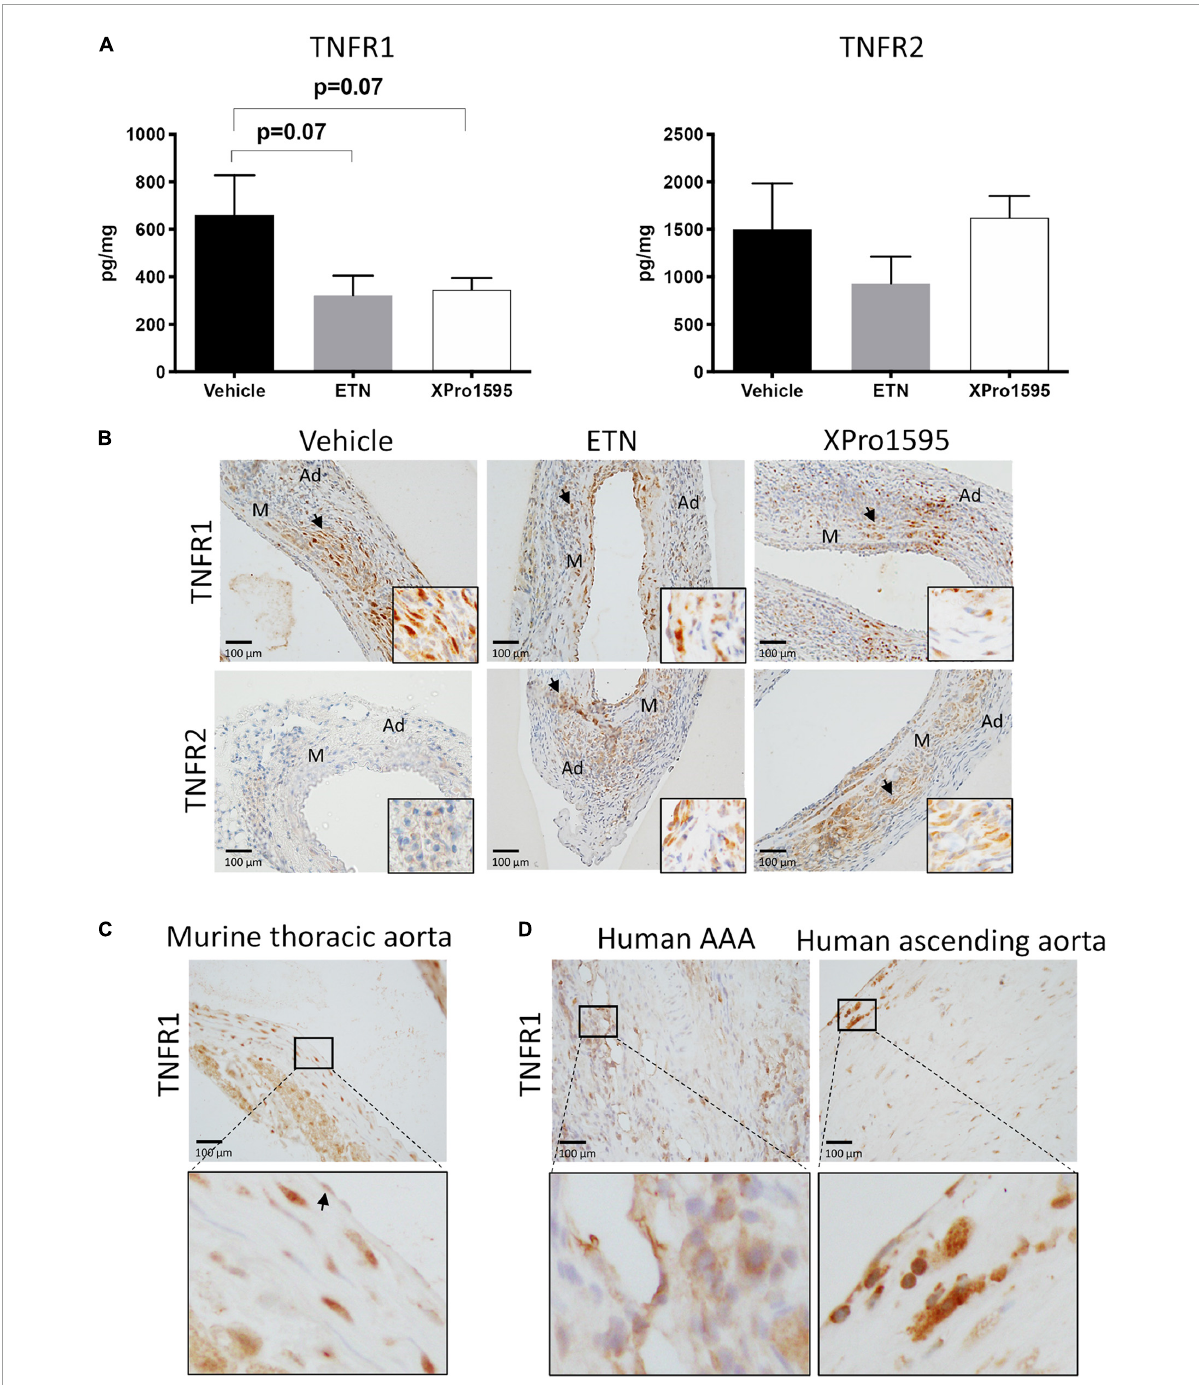
FIGURE2 TNF receptor protein levels and receptor localization in murine and human abdominal aortic tissue. (A) Aneurysmal protein levels of TNFR1 and TNFR2 from PPE- induced aneurysm in mice treated with vehicle (saline), ETN (20 mg/kg), or XPro1595 (20 mg/kg) ( n = 3–5). Data are shown as mean SEM. A non-significant trend was detected in TNFR1 levels by one-way ANOVA using Bonferroni test for multiple comparisons. (B) Representative distribution of TNFR1 and TNFR2 in the PPE-induced AAA wall after treatment with saline, ETN, or XPro1595 for 14 days ( n = 3–5). (C) TNFR1 distribution in unchallenged thoracic murine aorta. (D) Distribution of TNFR1 in human AAA specimens ( n = 2) and human ascending aortas ( n = 2). Black arrowheads indicate positive stained cells. M, media; Ad,